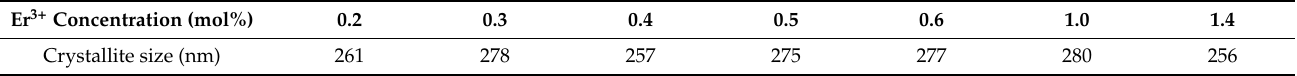
Table 2. The average crystallite sizes of nano-phosphors.